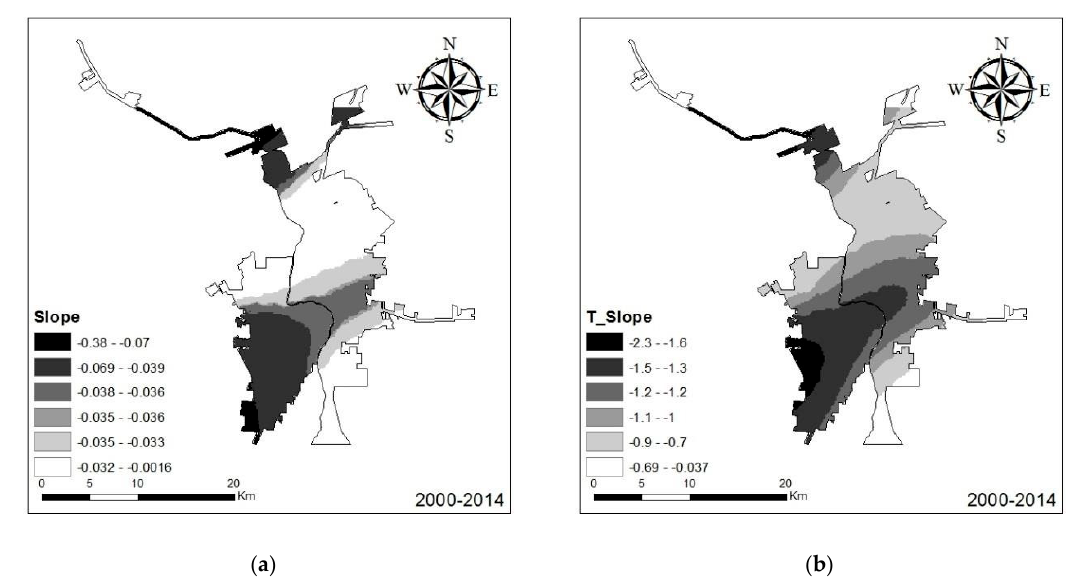
Figure 7. Logistic GWR results: estimated coefficient ( a ) and T-statistic surfaces ( b ): slope, 2000–2014.